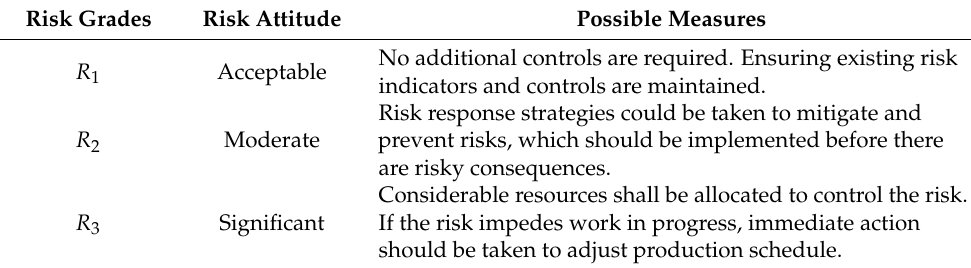
Table 3. Classification of risk grades and possible action to be